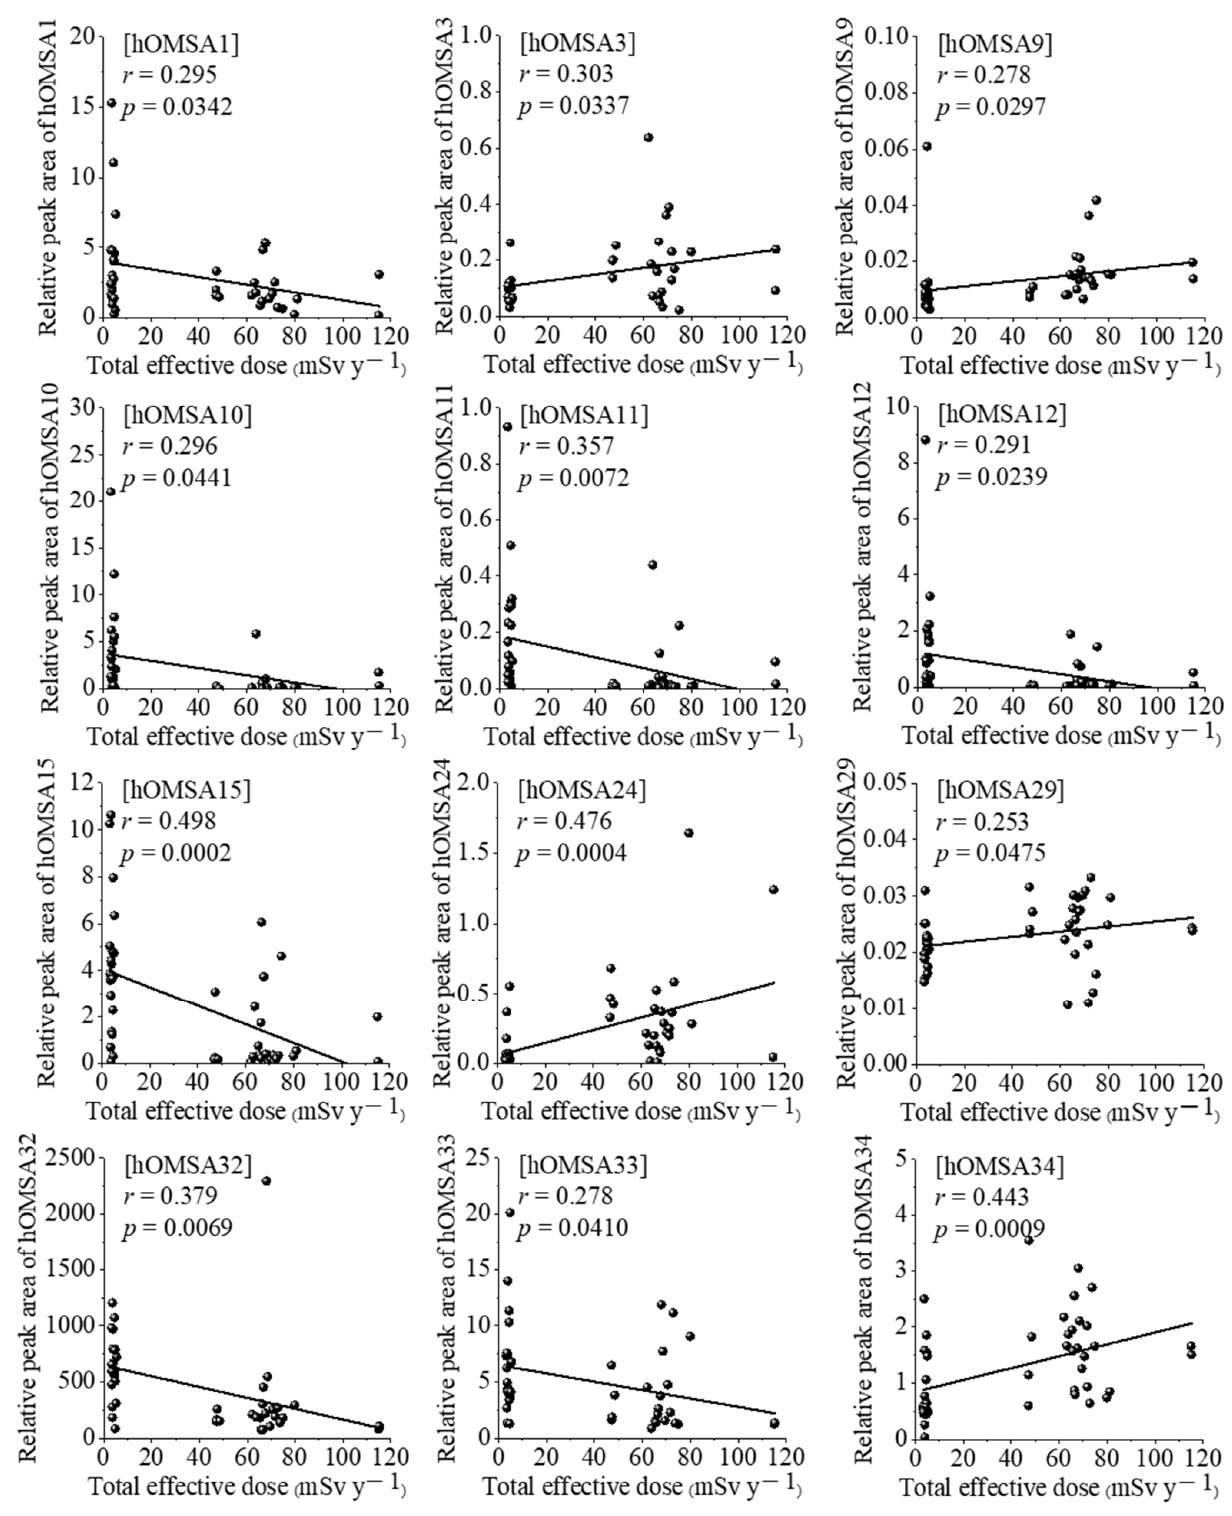
Figure 2. The linear fitting for forecasting the total effective radiation dose using the oxidative modification sequence of HSA. The linear fitting for forecasting the total effective radiation dose by measuring the oxidative modifications of 12 acid amino sequences of HSA: hOMSA1, hOMSA3, hOMSA9, hOMSA10, hOMSA11, hOMSA12, hOMSA15, hOMSA24, hOMSA29, hOMSA32, hOMSA33, and hOMSA34. R indicates the correlation coefficient value, and p < 0.05 was considered statistically